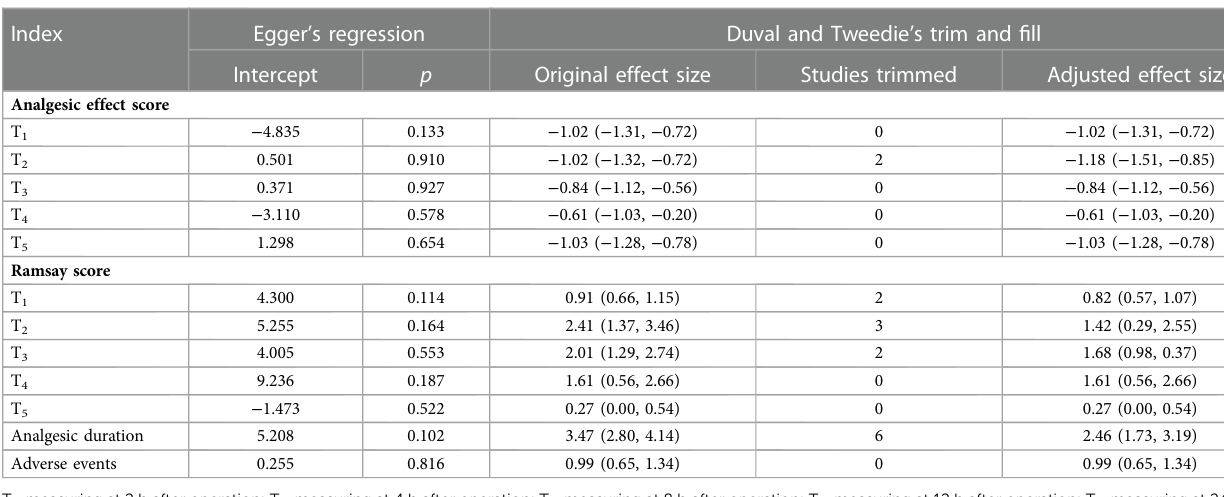
TABLE 2 Evaluation of publication bias and sensitivity